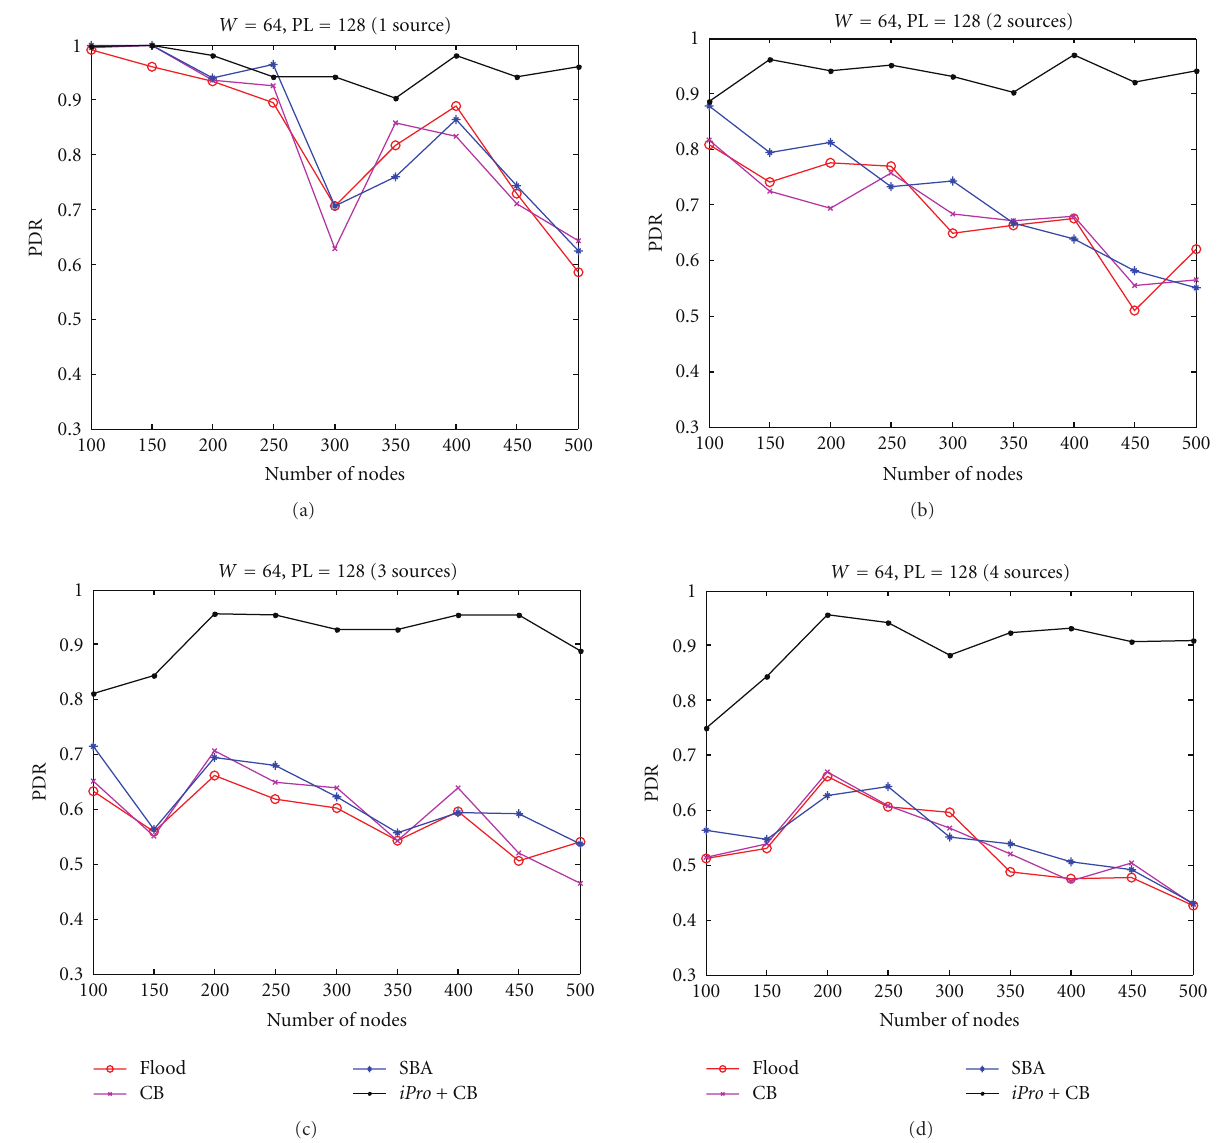
Figure 7: PDRs of multisource multihop broadcasting scenario when W =